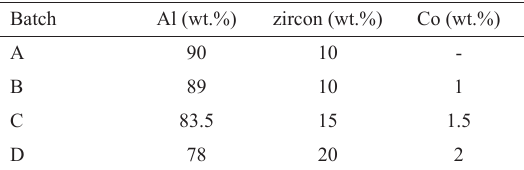
Table 1: Different compositions of batches.